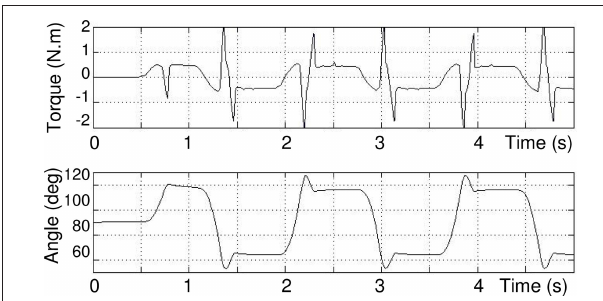
Figure 7 | Commanded torque (above) and angular position (below) of joint measured by sensory neurons, θ